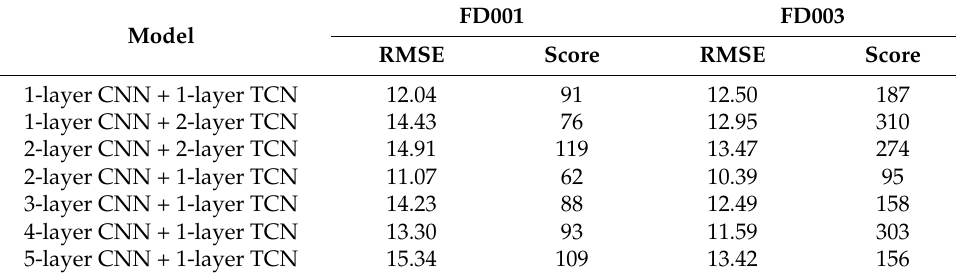
Table 4. Effect of different model layers.